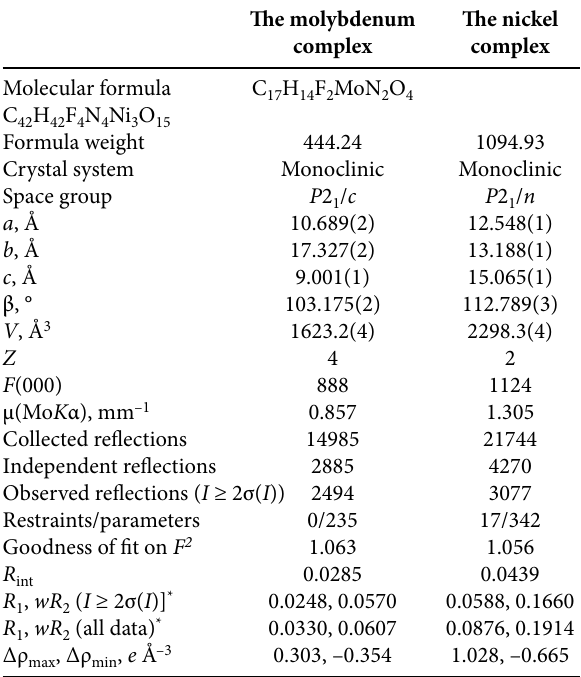
Table 1. Crystallographic data and structure refinement for the complexes The